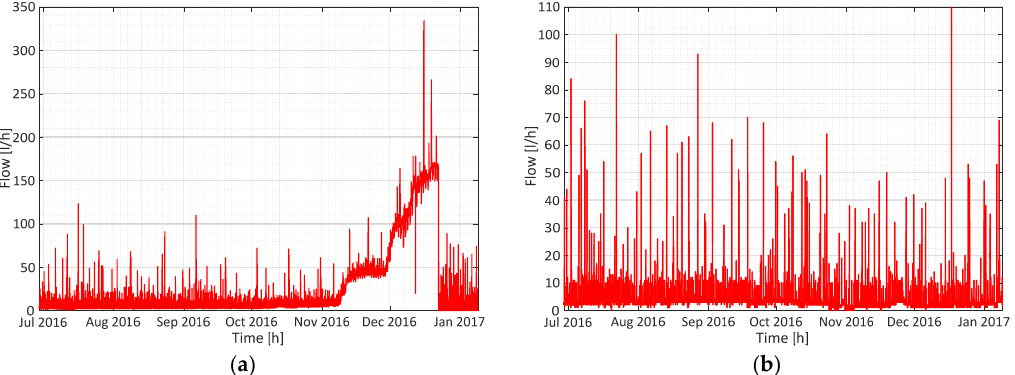
Figure 4. ( a ) Time series of hourly consumptions of a user affected by a large leak; ( b ) Time series of hourly consumptions of a user affected by a small leak.